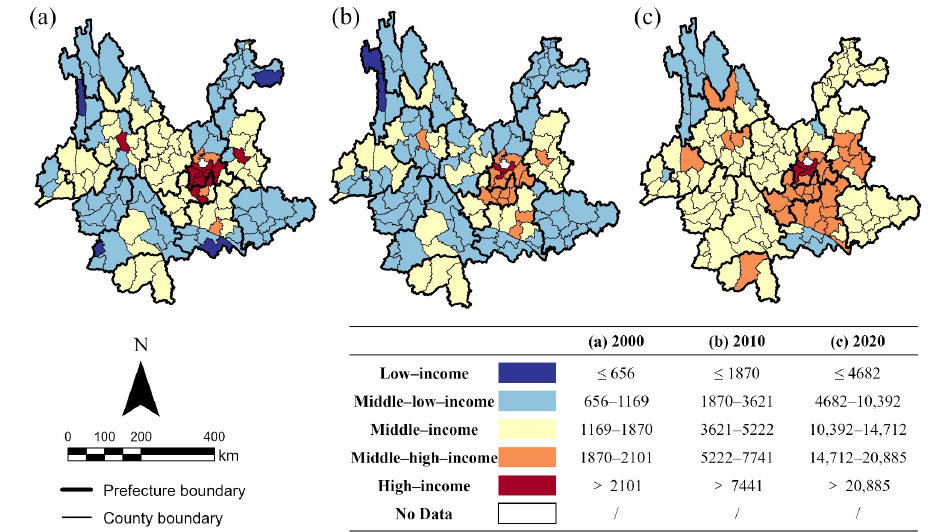
Figure 3. Spatial pattern of rural income growth by income quintile in: ( a ) 2000, ( b ) 2010, and ( c ) 2020.